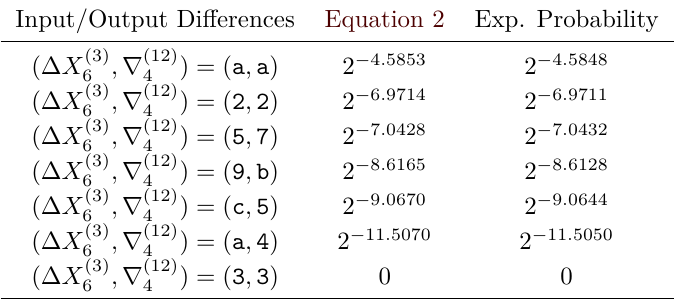
Table 4: Comparison between the theoretical and experimental probabilities of the boomerang switch over 10 rounds of WARP . Input/Output Differences Equation